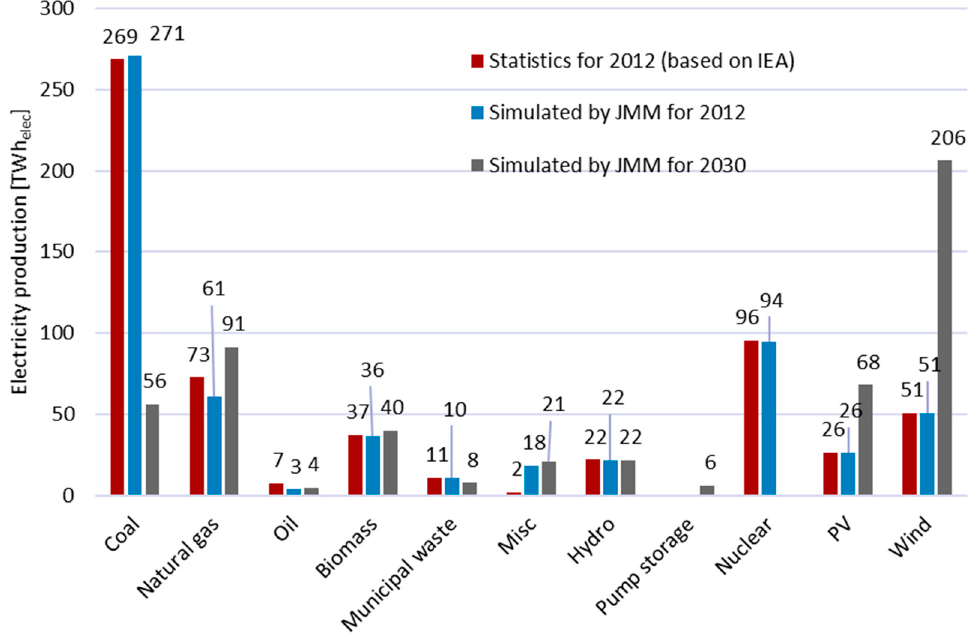
Figure 5. Results of JMM for the simulated annual production mix in the German power sector in 2012 (historic and simulated) and in 2030.